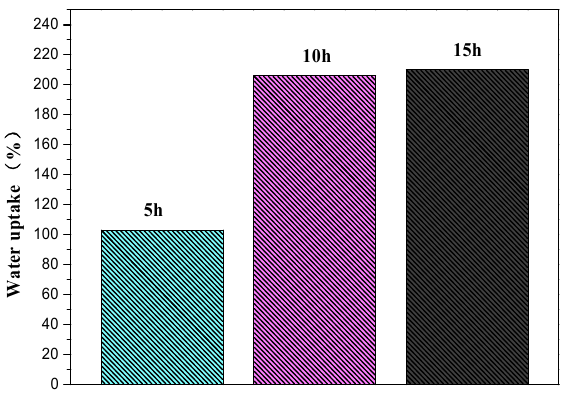
Figure 3. Water uptake of PSF-PDA / PEI with selected DA / PEI concentration (1:1 g / L) membranes at di ff erent deposition